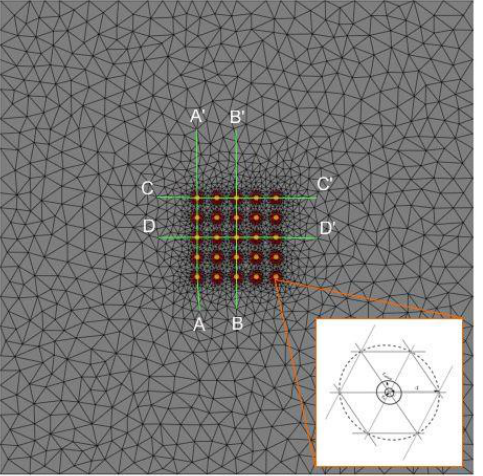
Figure 1. Non-uniform grid model of the study area and 25 borehole heat exchangers (2D), cross-section lines (green). Spatial discretization of BHE nodes (in frame) according to [27].